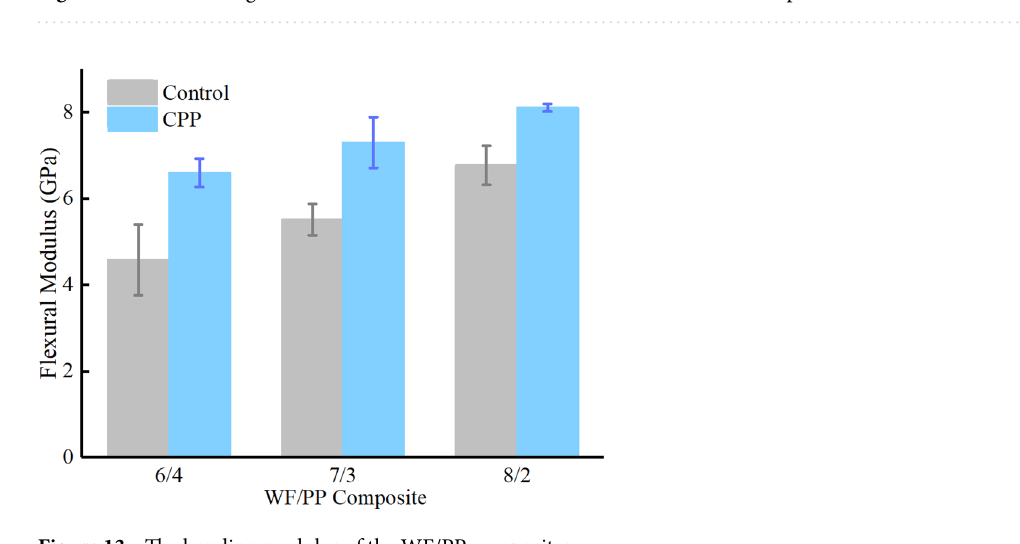
Figure 12. The bending strain versus the flexural stress of the veneered WF/PP composites.